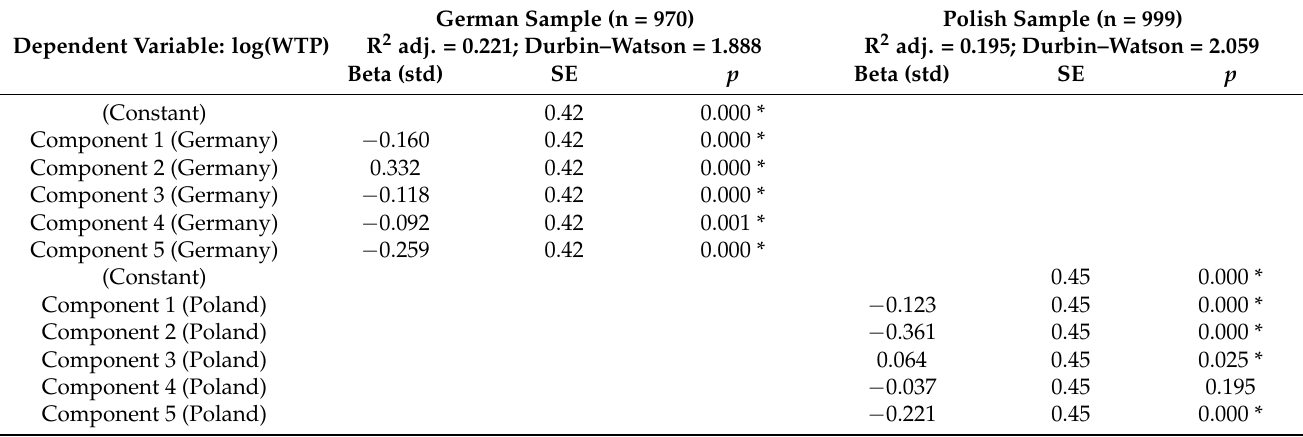
Table 5. Linear regressions conducted separately for samples from Germany and Poland, explaining support for climate policy as measured by log(WTP) through the components identified in the factor analysis. Statistically significant variables, at p < 0.05, are marked with